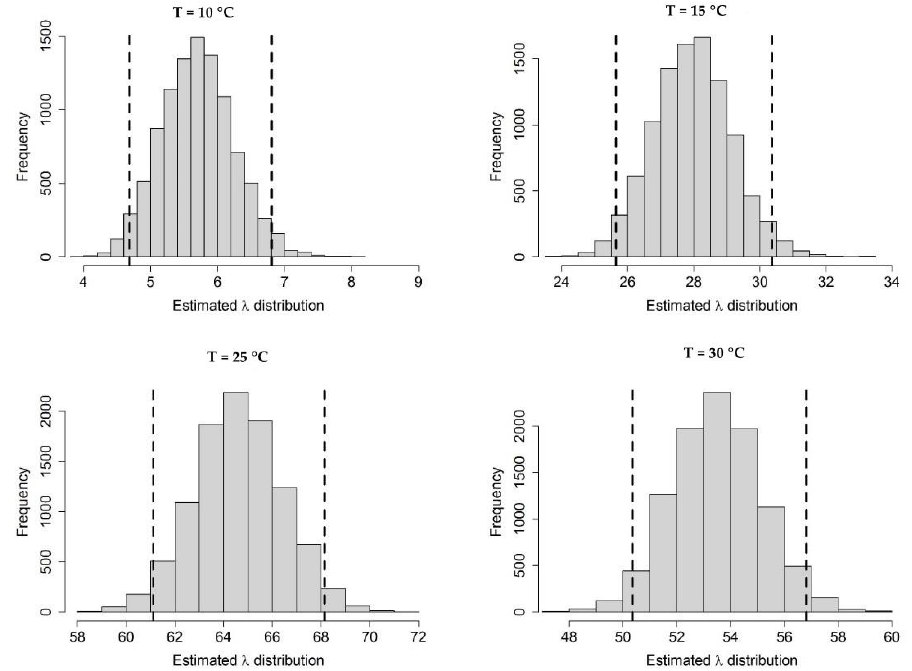
Figure A5. Estimated posterior distributions of Λ A (T), the average adult female longevity (days) at 10, 15, 25, and 30 °C. Dashed black lines represent the 2.5 and 97.5 quantiles.